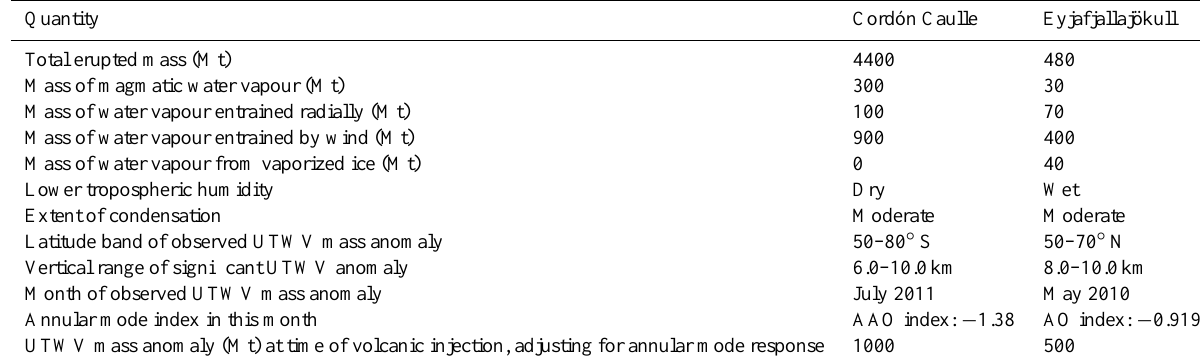
Table 1. Inputs and outputs of volcanic water vapour mass derived from bottom-up and top-down approaches. Quantity Cordón Caulle Eyjafjallajökull Total erupted mass (Mt) 4400 480 Mass of magmatic water vapour (Mt) 300 30 Mass of water vapour entrained radially (Mt) 100 70 Mass of water vapour entrained by wind (Mt) 900 400 Mass of water vapour from vaporized ice (Mt) 0 40 Lower tropospheric humidity Dry Wet Extent of condensation Moderate Moderate Latitude band of observed UTWV mass